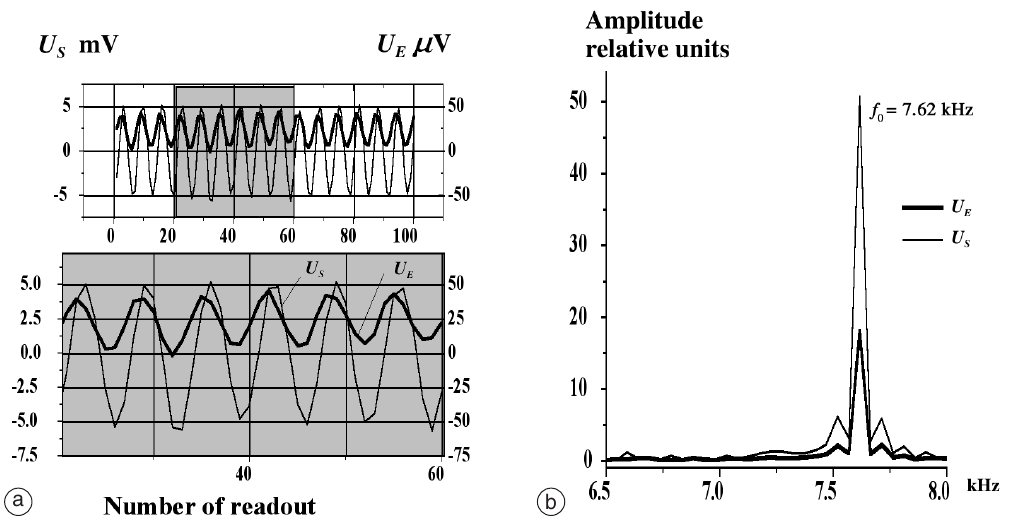
Fig. 7a,b. MSO of the first type, dry sample: a) electric ( U E ) and acoustic ( U S ) signals; b) spectra of the sig- nals U E and U S